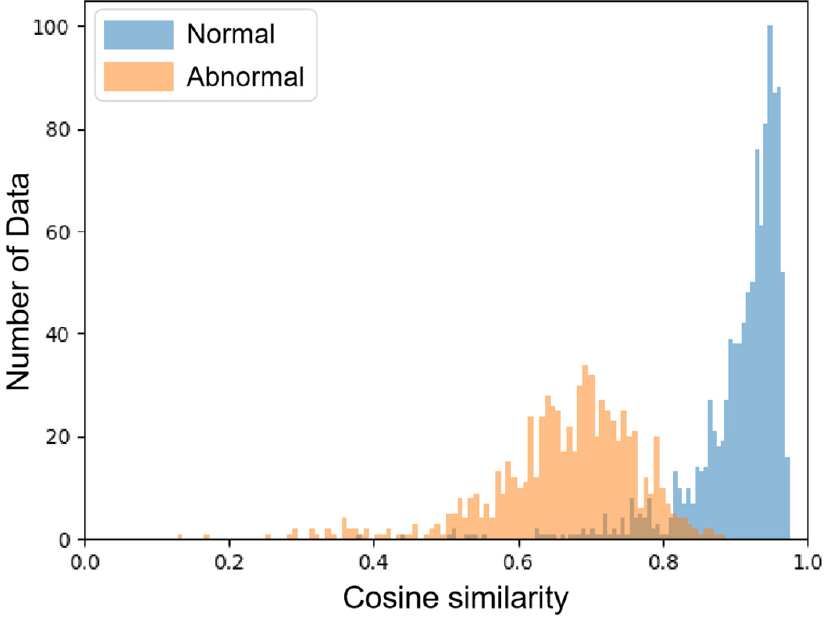
Figure 18. The distribution of cosine similarity between input and restored chips. Ship chips and false alarms are indicated in blue and orange respectively.